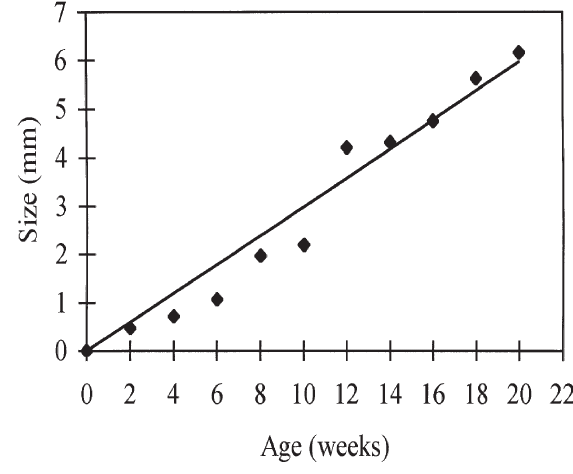
F IG . 2. – Biweekly settlement of Balanus trigonus on recruitment plates and relation to its abundance on succession plates.